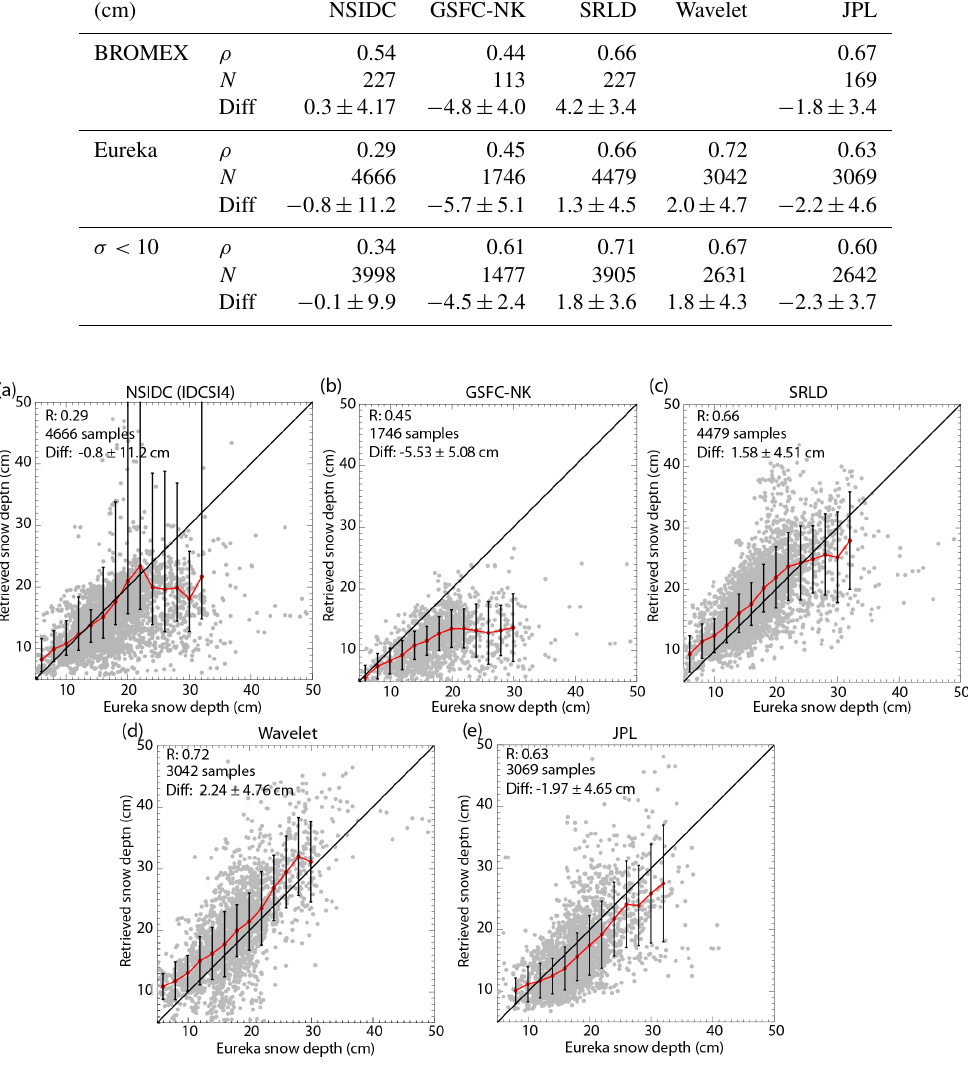
Figure 5. Comparison of five algorithms with field measurements from Eureka: (a) NSIDC, (b) GSFC-NK, (c) SRLD, (d) Wavelet, and (e) JPL. Scatterplot shows correlation ( R ) between the averaged snow depth samples; the number of samples and the mean and standard deviation of the differences are show on the top-left corner of plot. Error bars show standard deviation of samples in 2cm